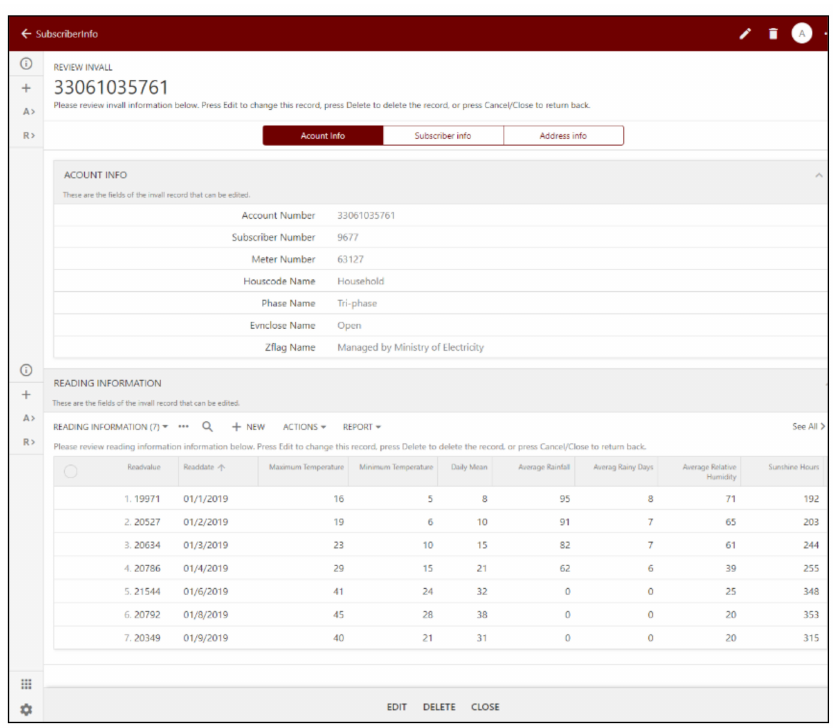
Figure 7. Update Account Information on